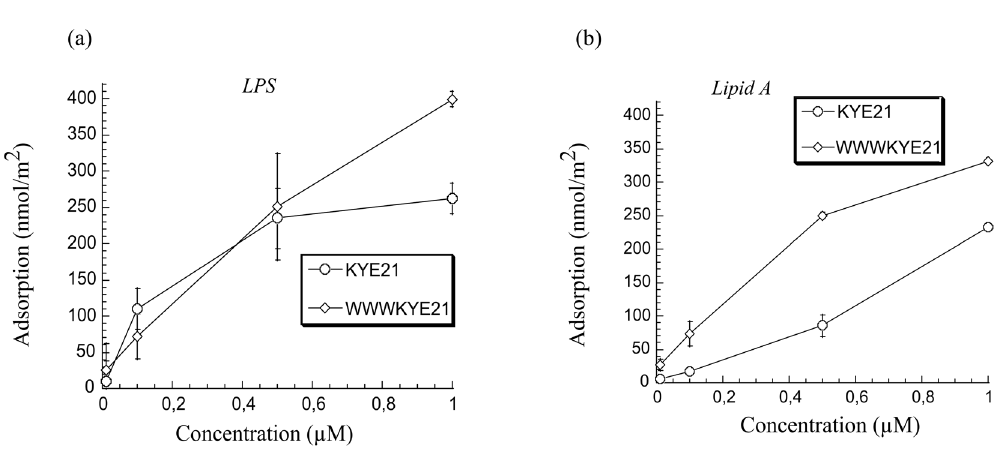
Figure 3. Peptide binding to LPS ( a ) and lipid A ( b ) in 10 mM Tris, pH 7.4. (n ≥